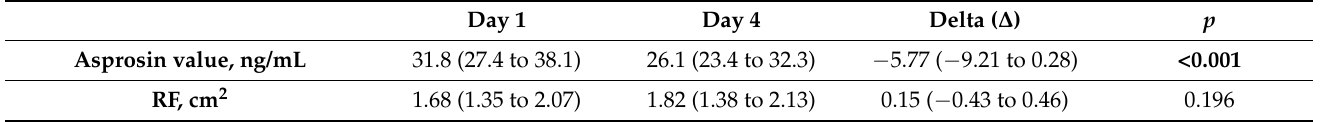
Table 2. Serum asprosin concentrations and RF values of participants on the first and fourth study days.